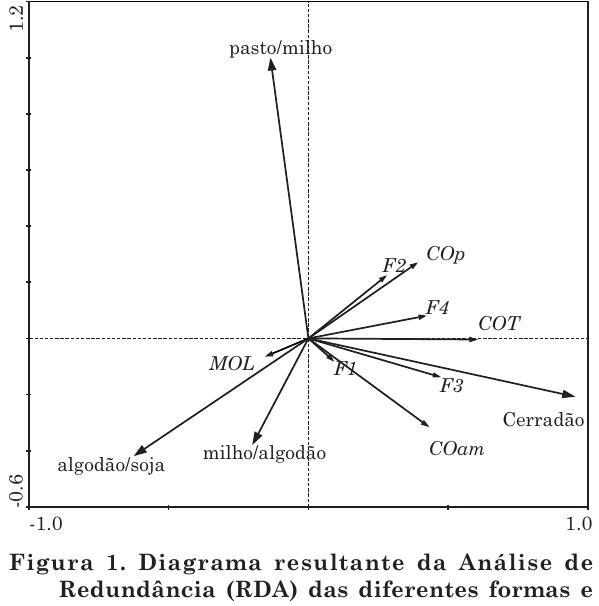
Figura 1. Diagrama resultante da Análise de Redundância (RDA) das diferentes formas e frações de carbono do solo em função das áreas avaliadas. COT: carbono orgânico total, COp: carbono orgânico particulado, COam: carbono orgânico associado aos minerais, MOL: matéria orgânica leve em água, F1, F2, F3 e F4: frações oxidáveis do carbono orgânico total. Valor de explicação do Eixo 1, 79,7 % e, do Eixo 2, 96,5